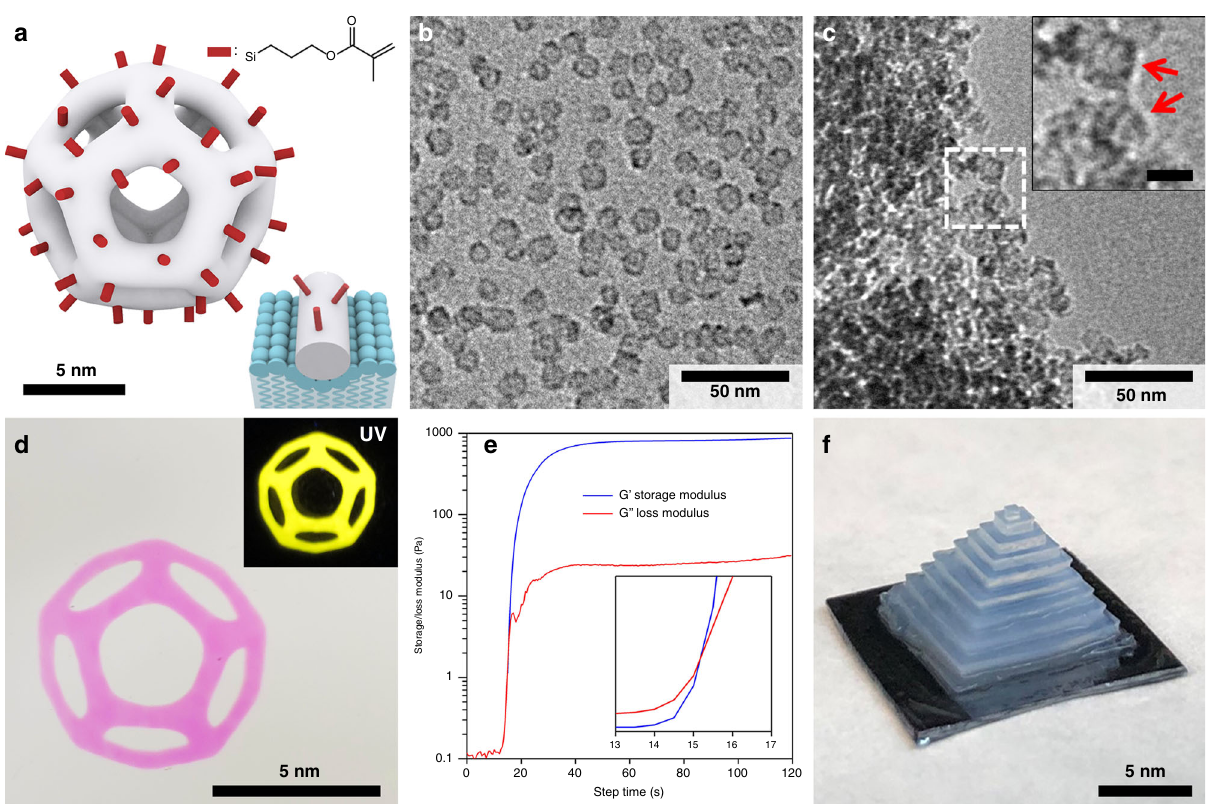
Fig. 1 Direct printing of mesoporous parts. Illustration ( a ) and TEM image ( b ) of silica cages functionalized with methyl methacrylate groups (inset in a : illustration of a cage strut partially wrapped by the surfactant micelle surface, in blue). c TEM image of a piece of a printed part (inset: zoom in, red arrows point to clearly visible cage structures, scale bar 10 nm). d Photograph of a pattern printed on a glass substrate with dye-functionalized cages (inset: photograph under UV illumination). e Rheology measurements, including storage modulus (G ’ , blue line) and loss modulus (G ” , red line), of the PLIC ink under UV irradiation (inset: zoom in to the region around the gel point). f Photograph of a multilayer 3D structure printed from the PLIC